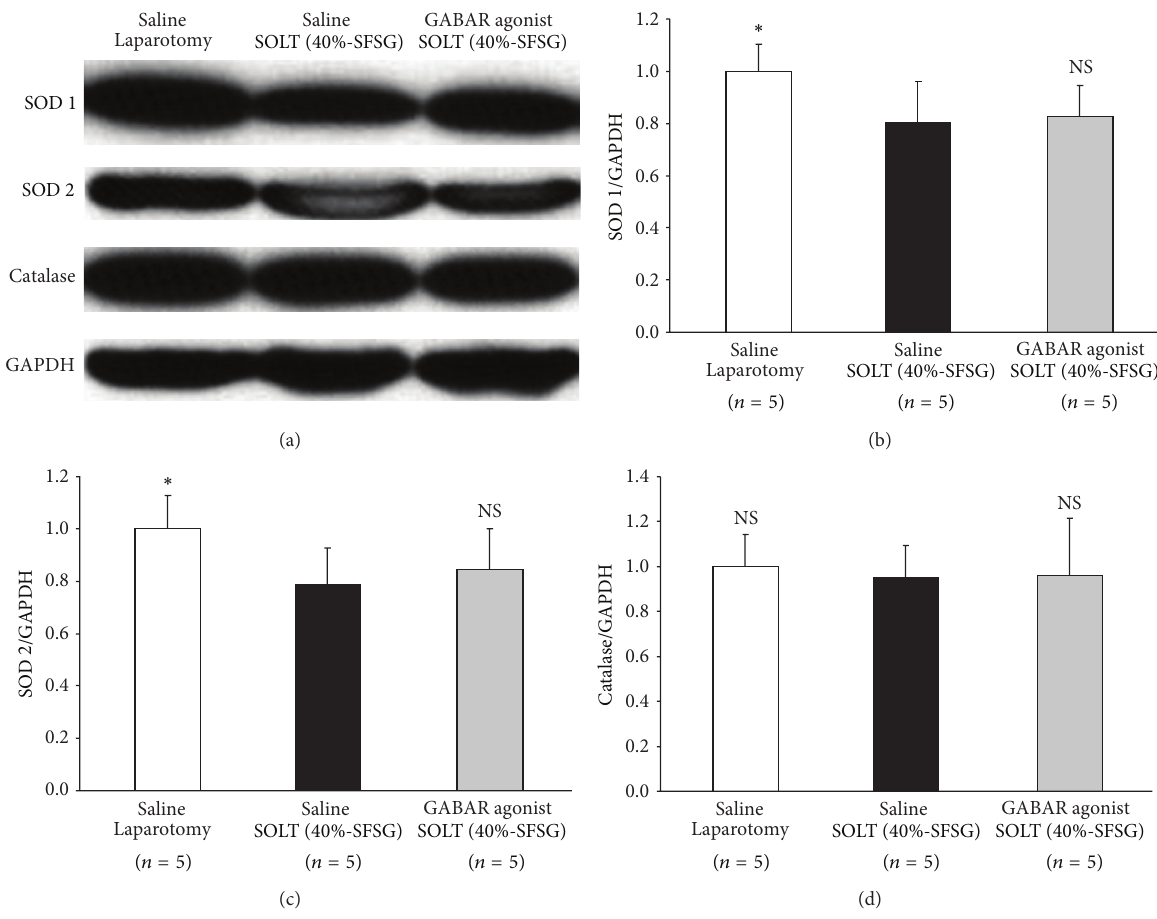
Figure 8: Western blot analyses of SOD 1, SOD 2, and catalase. (a) Intensities of SOD 1, SOD 2, catalase, and GAPDH. (b) Normalized SOD 1. There were significant differences between laparotomy and SOLT with saline ( 𝑃 < 0.05 ∗ ) but no differences between SOLT with saline and SOLT with GABAR agonist. (c) Normalized SOD 2. There were significant differences between laparotomy and SOLT with saline ( 𝑃 < 0.05 ∗ ) but no differences between SOLT with saline and SOLT with GABAR agonist. (d) Normalized catalase. There were no significant differences between laparotomy and SOLT with saline and between SOLT with saline and SOLT with GABAR agonist. GABAR, 𝛾 -aminobutyric acid receptor; GAPDH, glyceraldehyde-3-phosphate dehydrogenase; NS, not significant ( 𝑃 ≥ 0.05 ); SFSG, small-for-size graft; SOD, superoxide dismutase; SOLT, split orthotopic liver